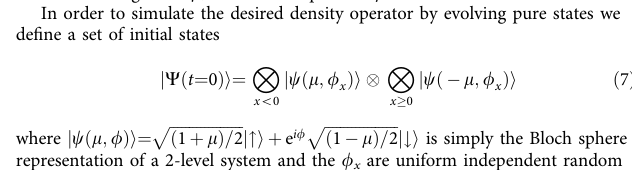
Figure 4 | Simulation complexity. ( a ) Von Neumann entanglement entropy S for the fully polarized initial state ( m ¼ 1) at the isotropic point D ¼ 1. ( b ) Operator space entanglement entropy S # for D ¼ 1 (blue) and D ¼ 2 (green), both for m ¼ p /1,800. Bipartition into two equal halves and a system size of n ¼ 320 are